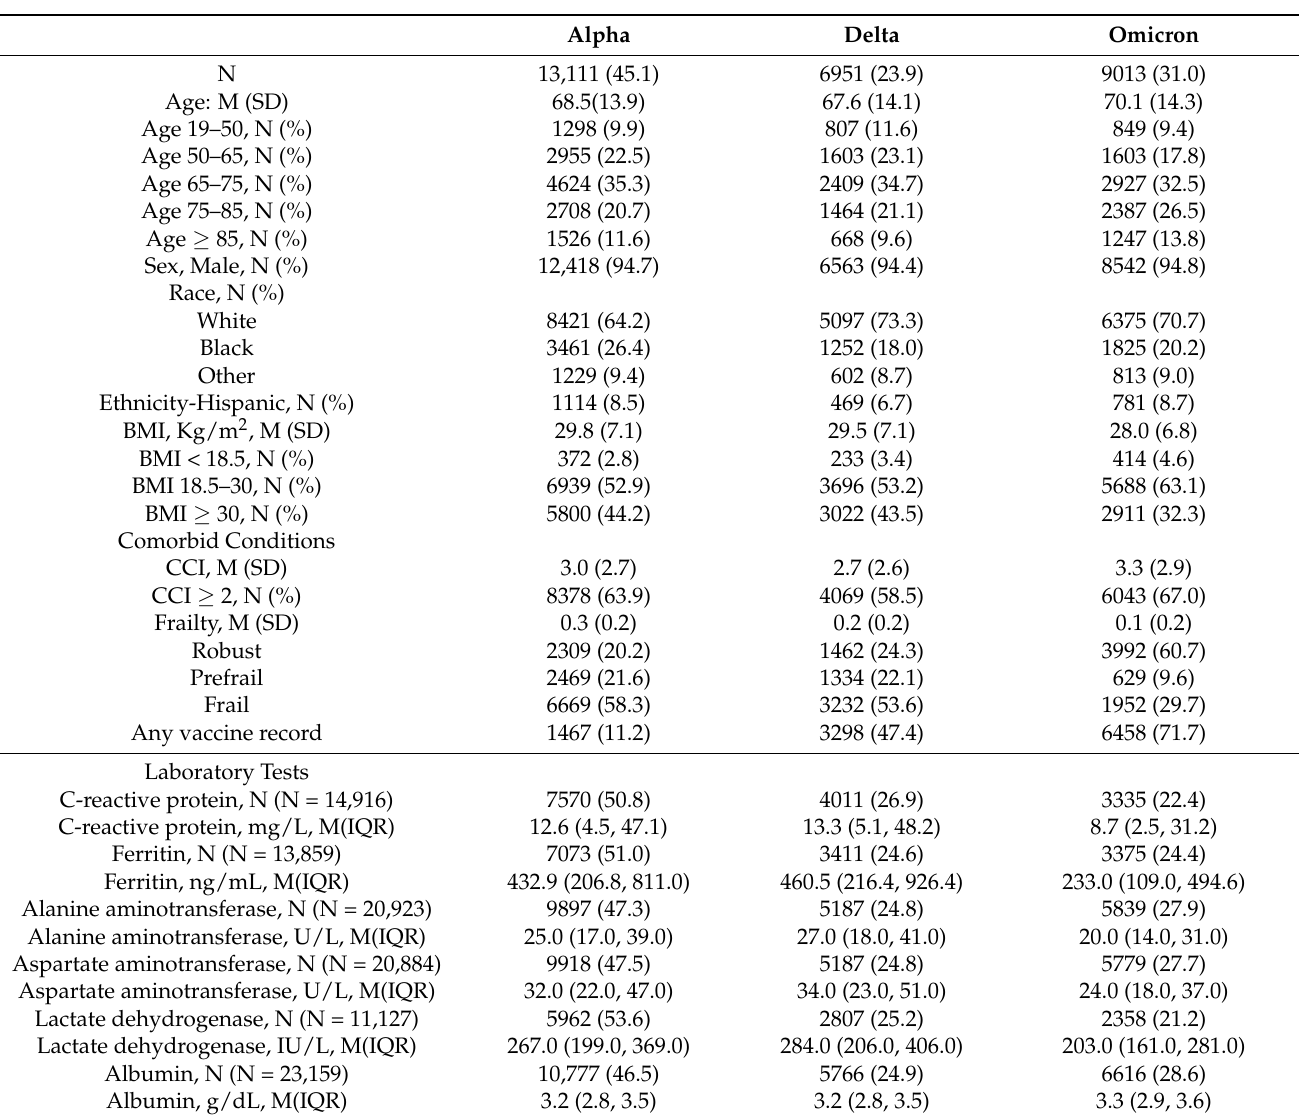
Table 1. Demographics and clinical characteristics in the Alpha, Delta, and Omicron variation groups among veterans with